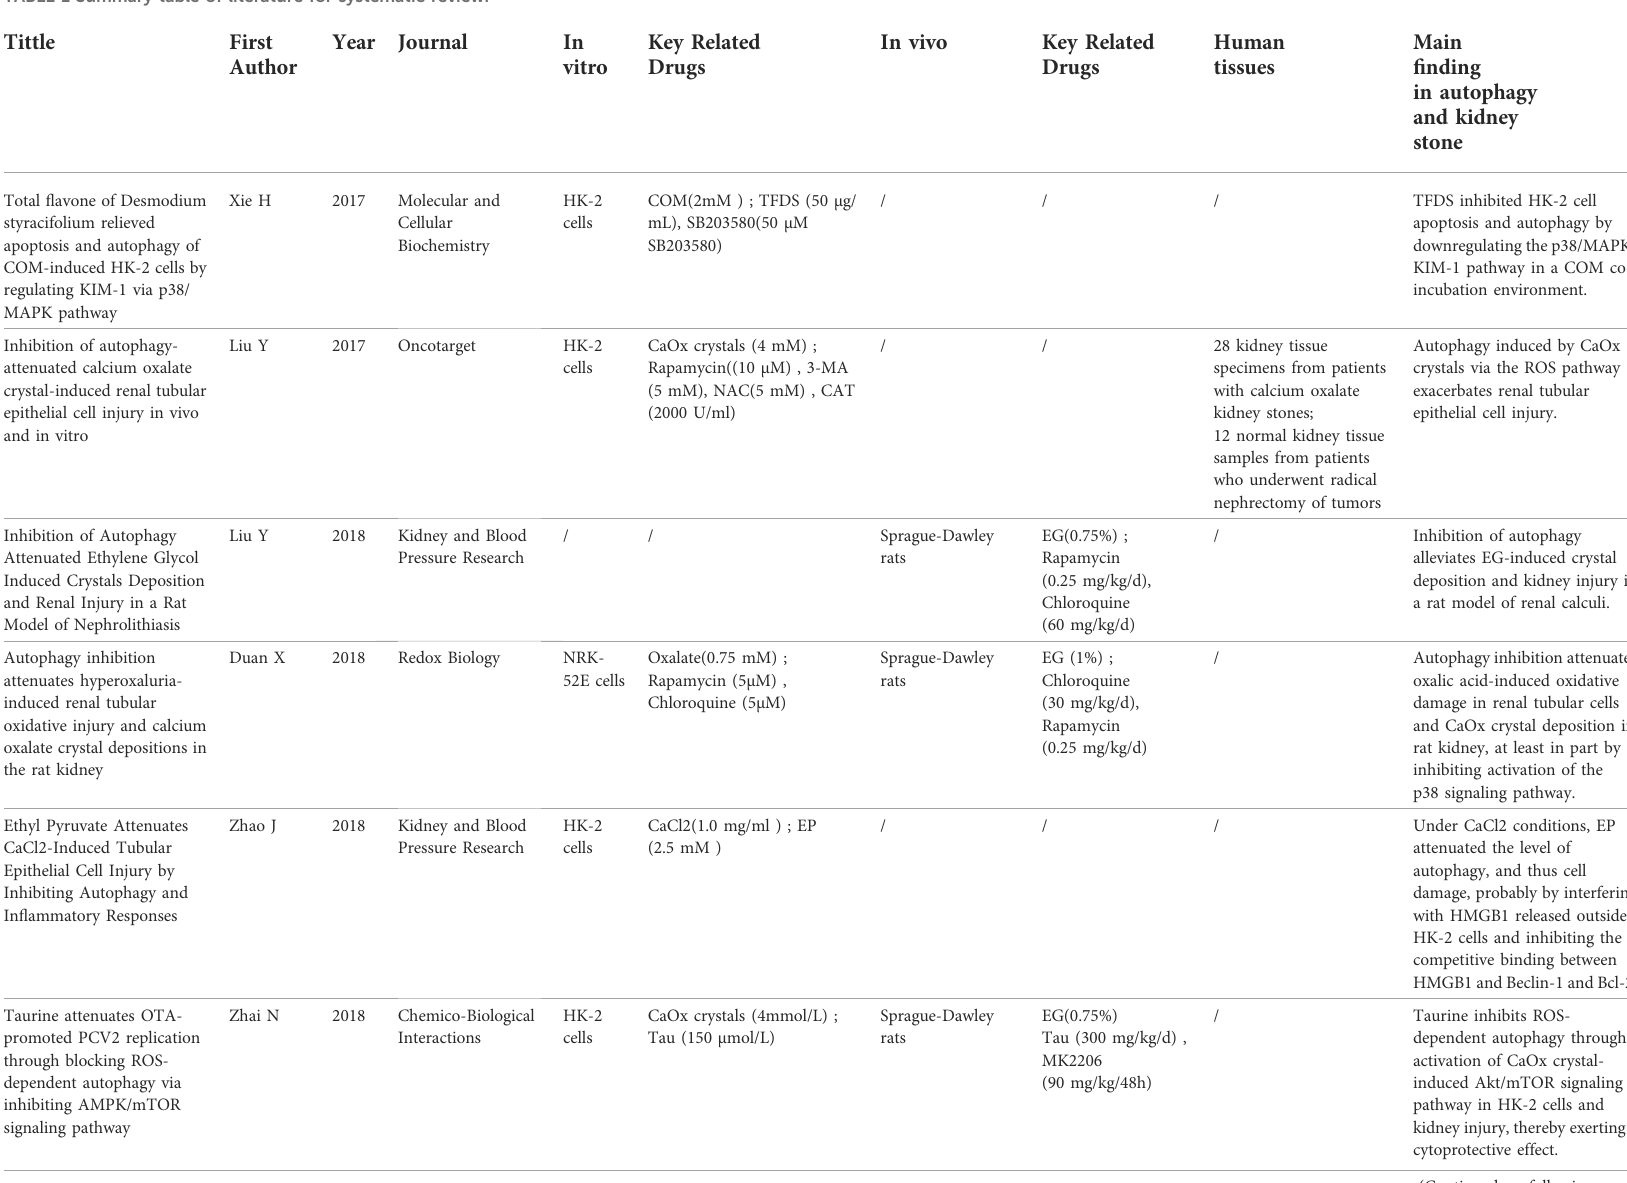
TABLE 1 Summary table of literature for systematic